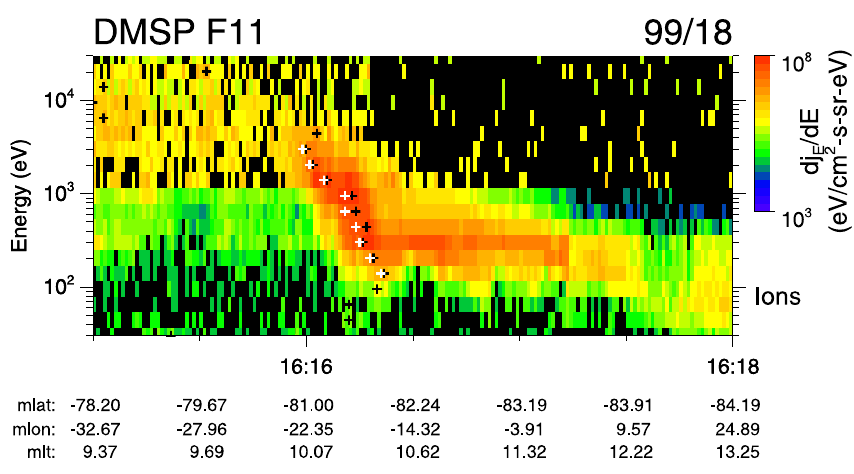
Fig. 13. The DMSP F11 ion spectrogram measured between 16:15 and 16:18 UT. The black crosses mark the peak differential energy flux [eVcm − 2 s − 1 sr − 1 eV − 1 ] in each energy channel, and the white crosses mark where the differential energy flux is 90% or less of the peak value.